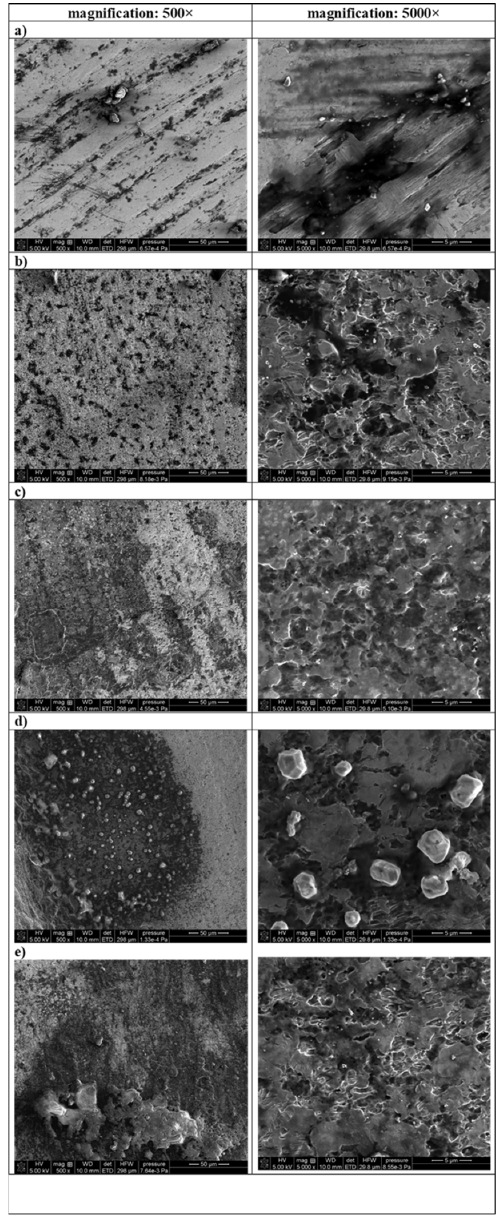
Figure 2. SEM images of the surfaces of titanium implant samples: ( a ) randomly selected site, ( b ) control, ( c ) L1: 1 × 15 s, ( d ) L2: 2 × 15 s, ( e ) L3: 3 × 15 s. ( b ) control, ( c ) L1: 1 × 15 s, ( d ) L2: 2 × 15 s, ( e ) L3: 3 × 15